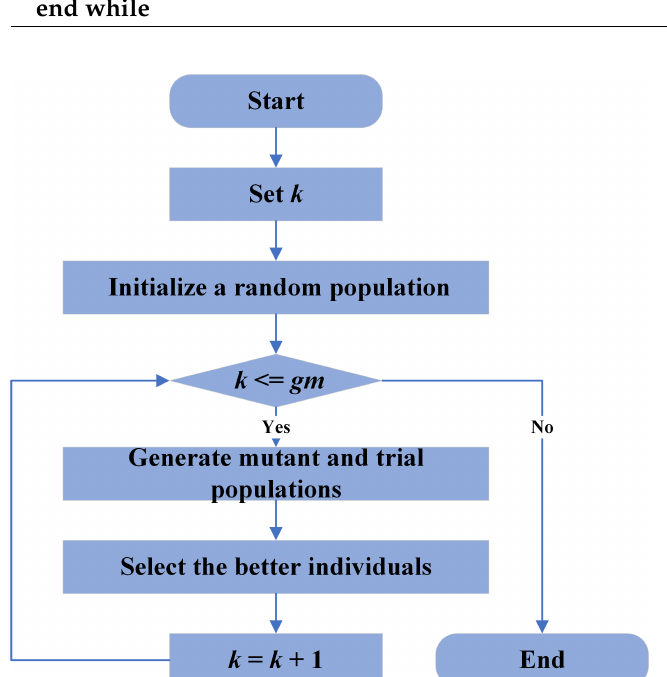
Figure 2. The flowchart of the DE algorithm.